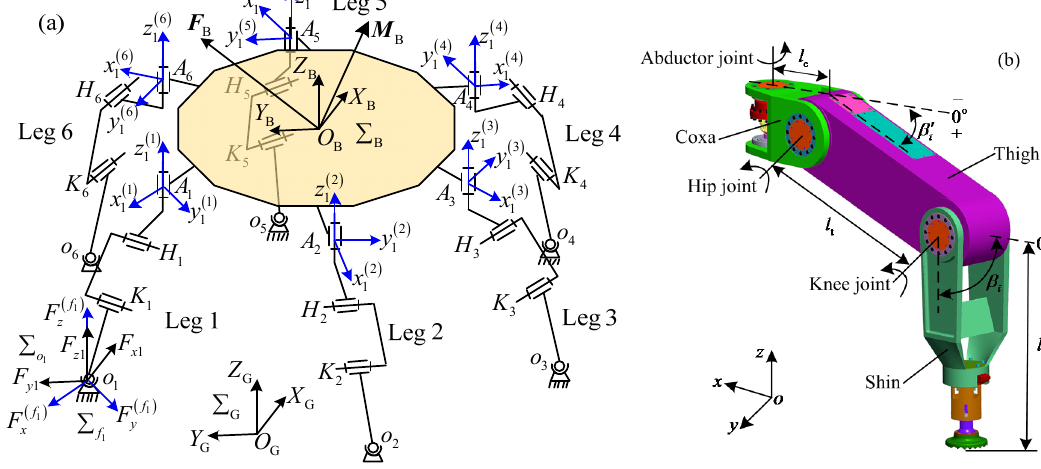
Figure 1. Electrically driven heavy ‐ duty six ‐ legged robot: ( a ) mechanism; and ( b ) structure of leg.